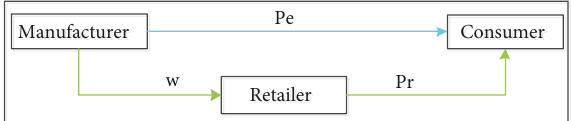
Figure 1: The dual-channel supply chain